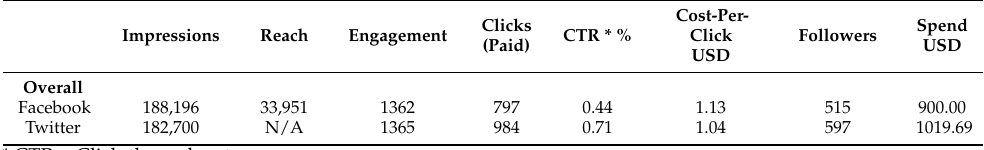
Table 4. Campaign dose key performance